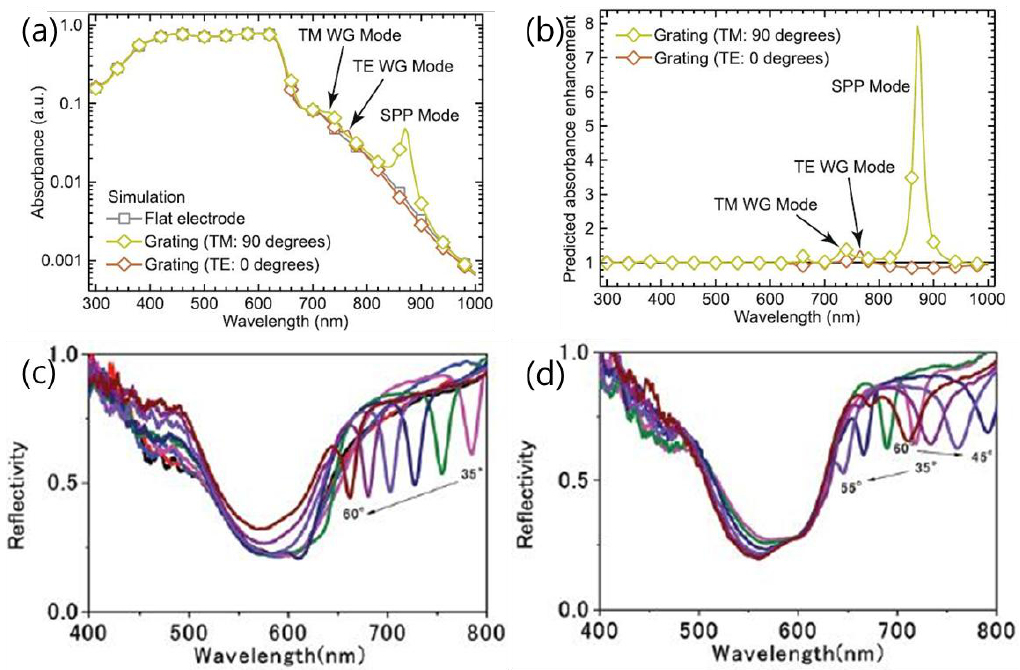
Figure 13. ( a ) Simulated absorbance spectra as a function of the incident light polarization relative to the grating period, for the active layer in a complete device stack incorporating the same Ag grating, with the corresponding absorbance for a device with a flat Ag electrode for comparison [56]; ( b ) the predicted polarization-dependent absorbance enhancement as a result of incorporating the nanostructured Ag grating electrode; ( c ) device EQE enhancement factor (see text for definition) for normal incidence with polarization parallel (TE; left) and perpendicular to the period of the grating (TM; right). Reflectivity measurements of inverted OSCs by illumination with TE (s-pol) ( d ) or TM (p-pol) [81]. Reprinted with permission from Refs. [56,81].